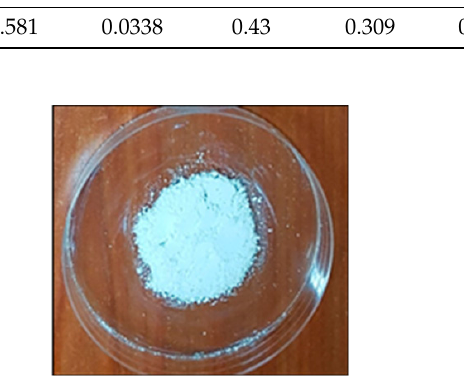
Figure 1. Photograph of TiO 2